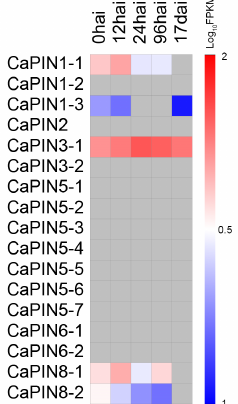
fungus Hemileia vastatrix . Hai and dai represent hours and days after inoculation, respectively. Grey squares represent no data. Grey squares represent no